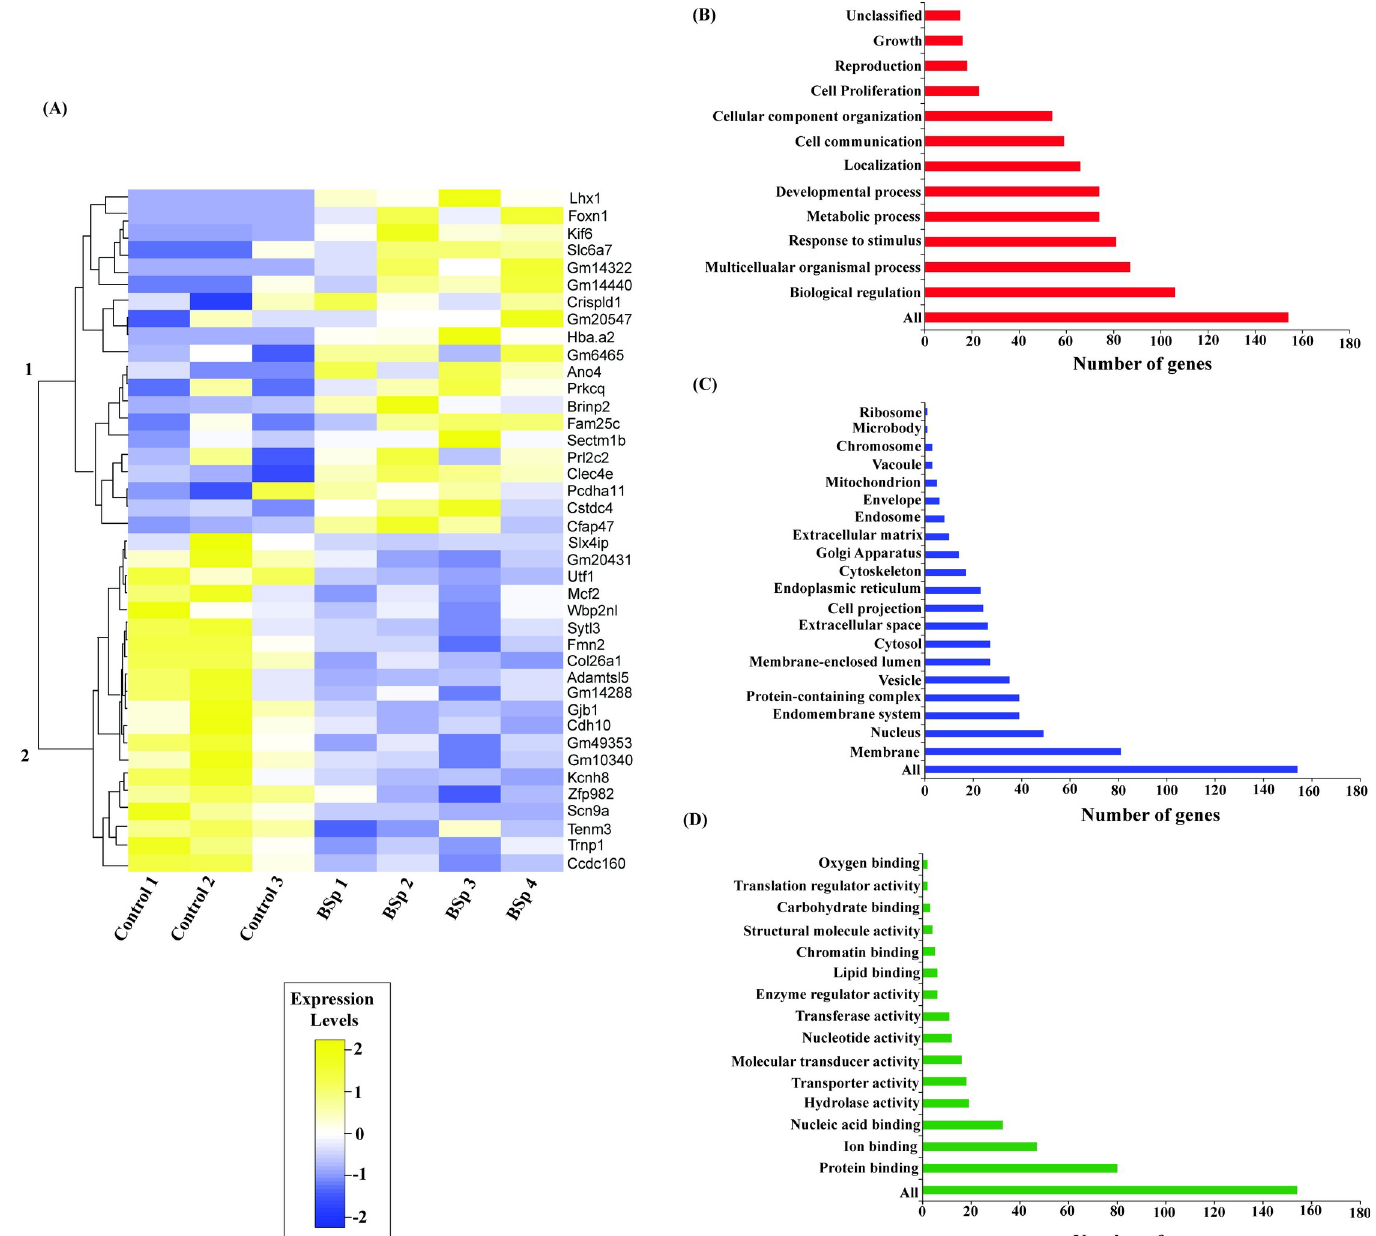
Fig 3. Maternal dietary administration of BSp influenced offspring transcriptome. (A) Heatmap representing top 20 upregulated and down-regulated target genes between the Control- and maternal fed BSp-born offspring mice based on q value. Each row corresponds to DE transcripts and each column represents biological replicates in Control (N = 3) and the BSp (N = 4) treatment groups. Blue color denotes lower expression levels and red color denotes higher expression levels. B-D, GO term analysis of DE transcripts for the maternal BSp treatment. Bar graph of GO enrichment analysis for DE transcripts in (B) Biological processes, (C) Cellular components and (D) Molecular